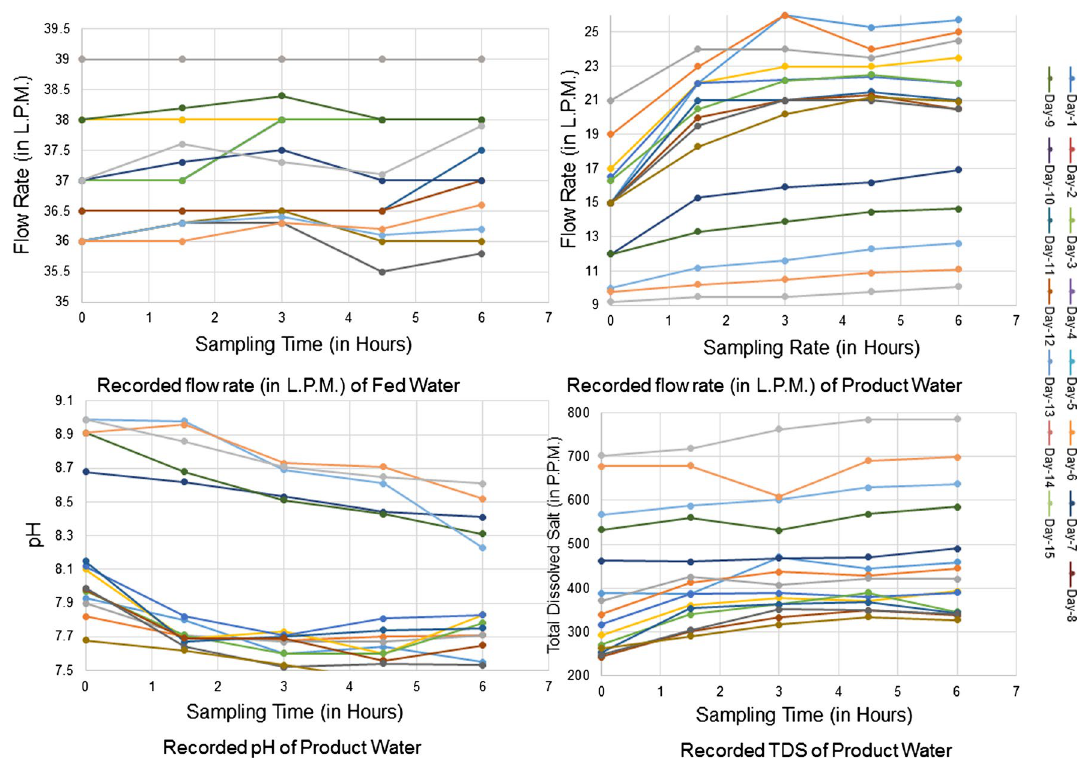
Fig. 6 Flow rate and water quality variation in feed and product water